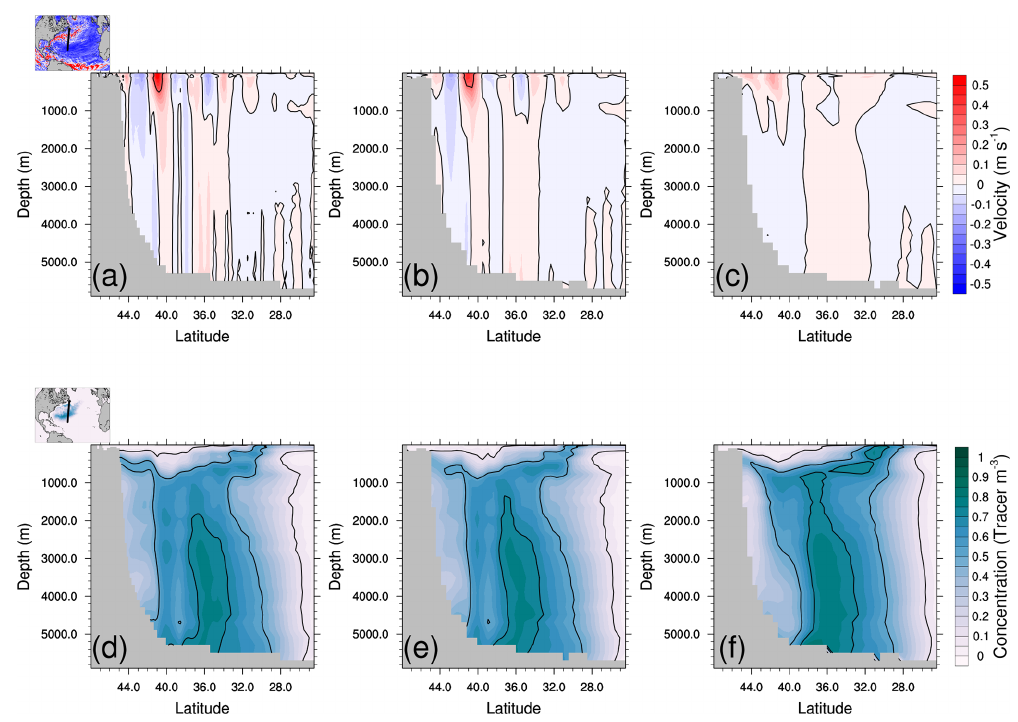
Figure 7. Vertical distribution of the zonal velocities (ms − 1 ) (a, b, c) and PATCH tracer (d, e, f) for HR (a, d) , HRCRS (b, e) and LR (c, f) configurations along the 55 ◦ W section in the Gulf